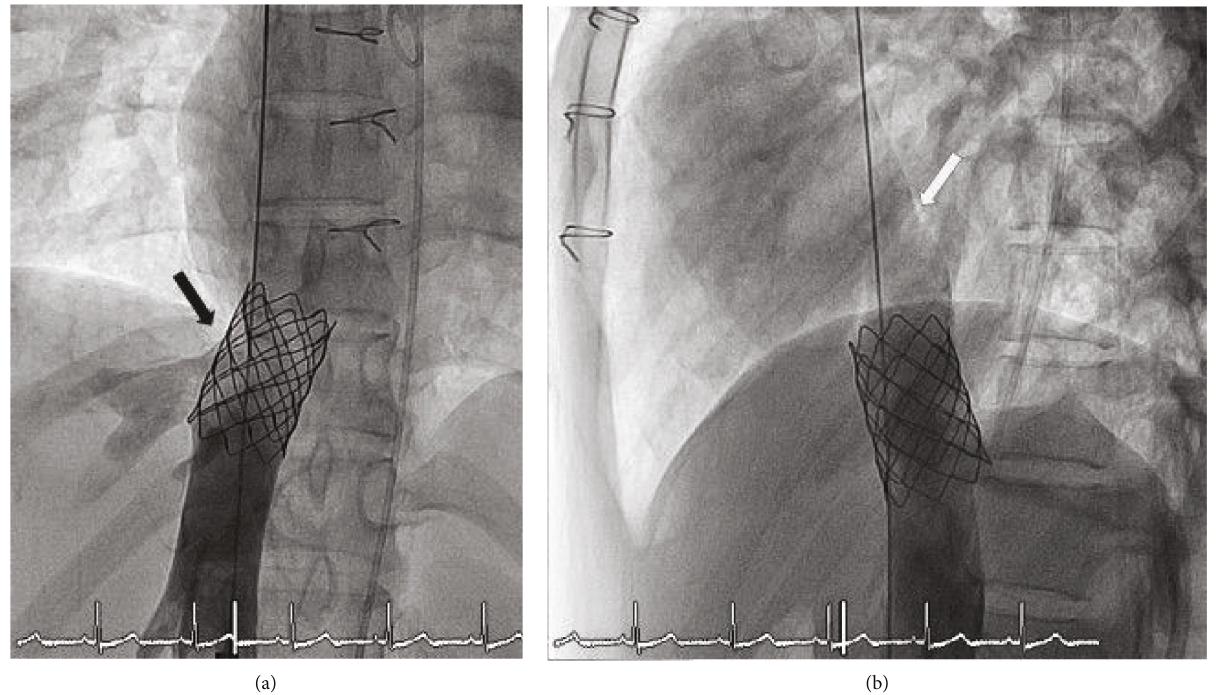
Figure 10: The bare stent, which was placed fi rst, was positioned at the inferior vena cava-right atrium junction ((a) anteroposterior and (b) lateral views on angiography). The decision was then made to position the lower end of the planned covered stent, which will be placed later, above the entrances of the right and also left hepatic veins (black arrow), and that the covered stent would overlap with the bare stent approximately 50%. It was also noted that the distal part of this covered stents should position just above the entrance of the right lower pulmonary vein (white arrow).